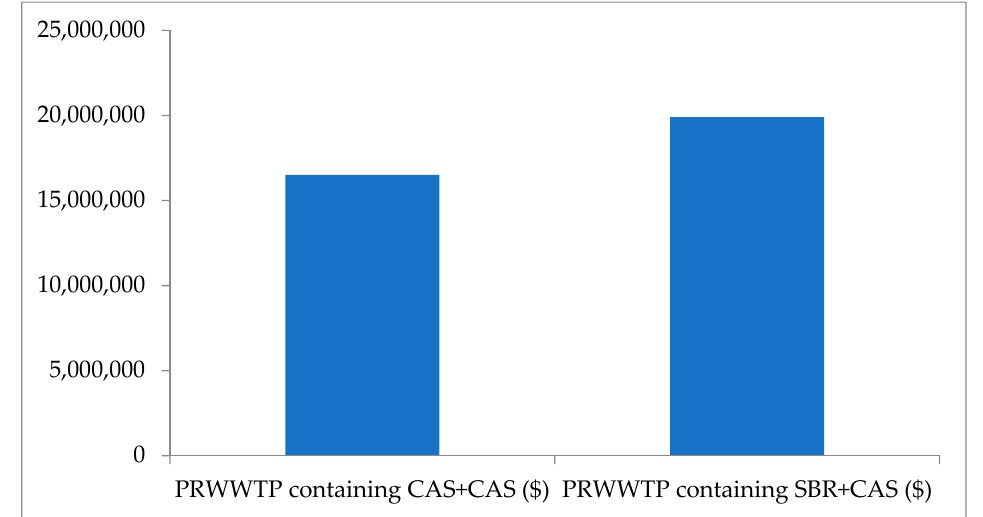
Figure 5. The total project construction cost ($) of the PRWWTPs containing CAS + CAS and SBR + CAS processes.